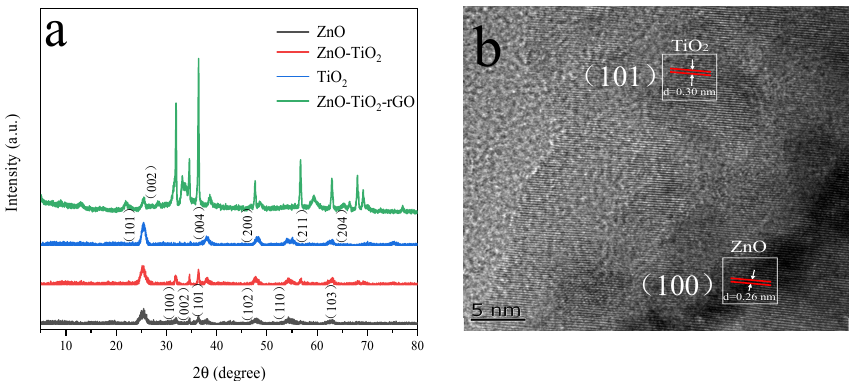
Figure 5. ( a ) XRD patterns of ZnO, TiO 2 , ZnO-TiO 2 , and ZnO-TiO 2 -rGO. ( b ) TEM high-resolution image of ZnO-TiO 2 -rGO.